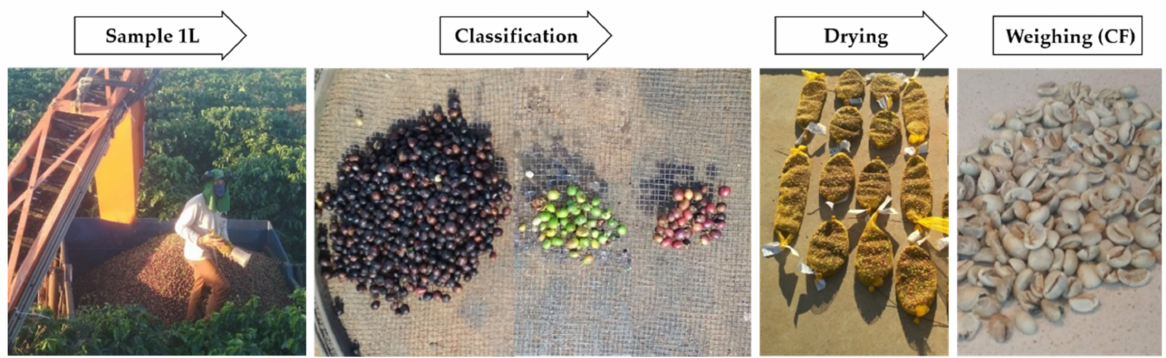
Figure 3. Collection flow and processes for obtaining the